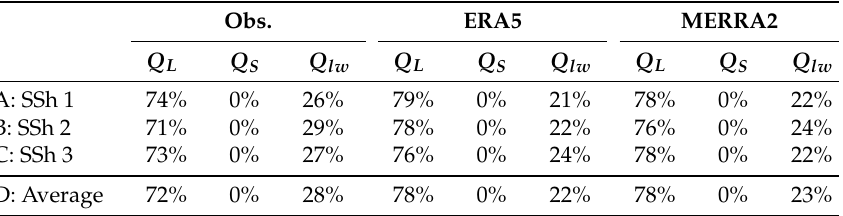
Table 4. As in Table 1 but for the summer Shamals. (A–C) Values during the three summer